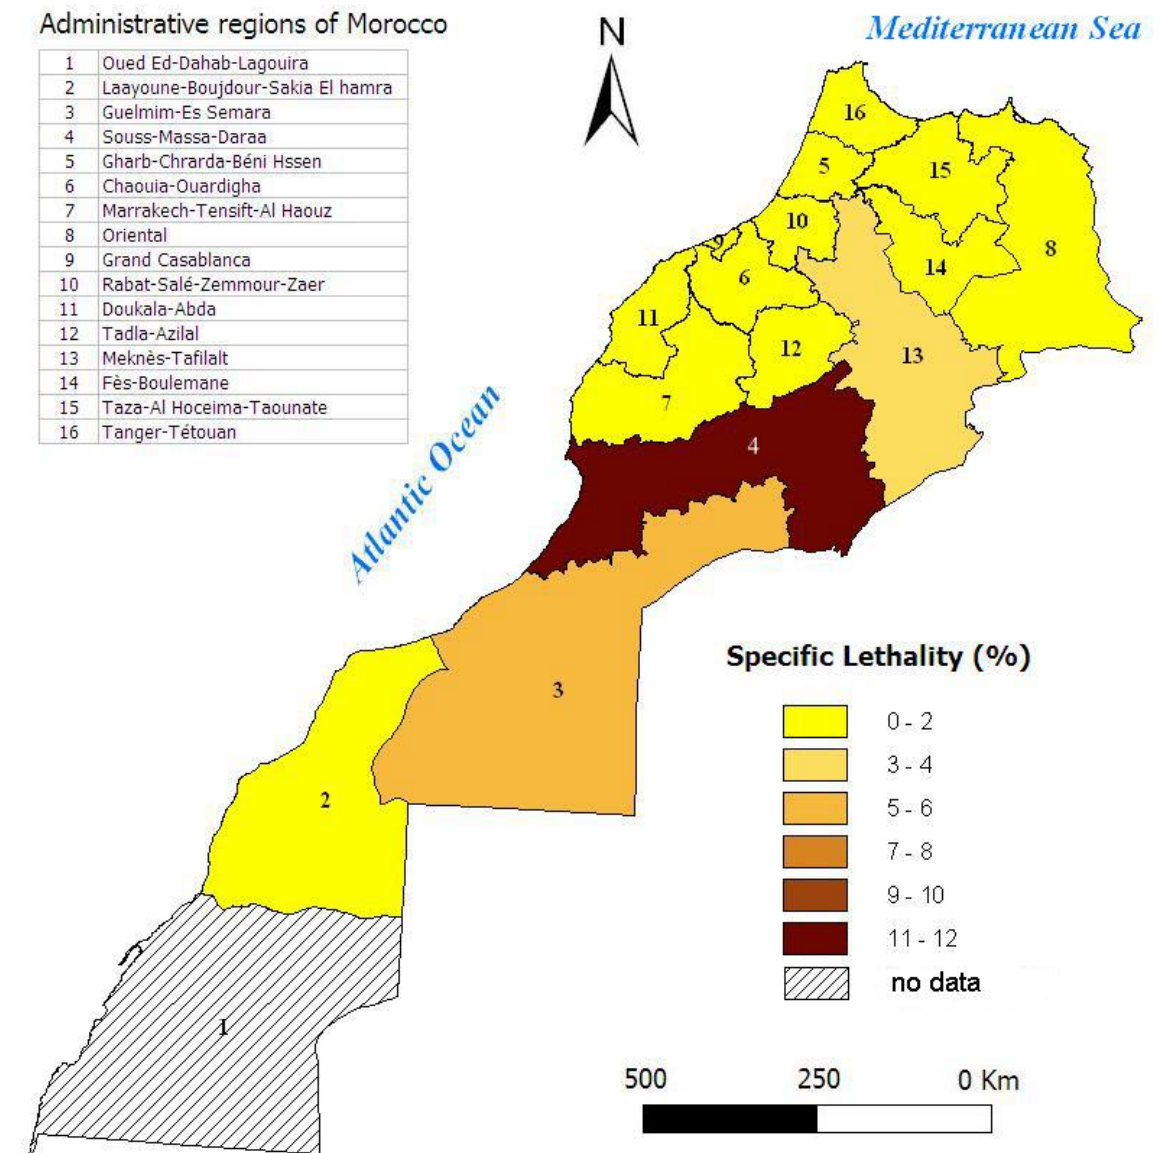
Figure 7. Distribution of snakebite specific lethality by administrative region of